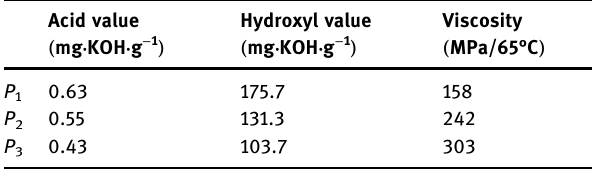
Table 1: Hydroxyl ester and viscosity of PCL diol